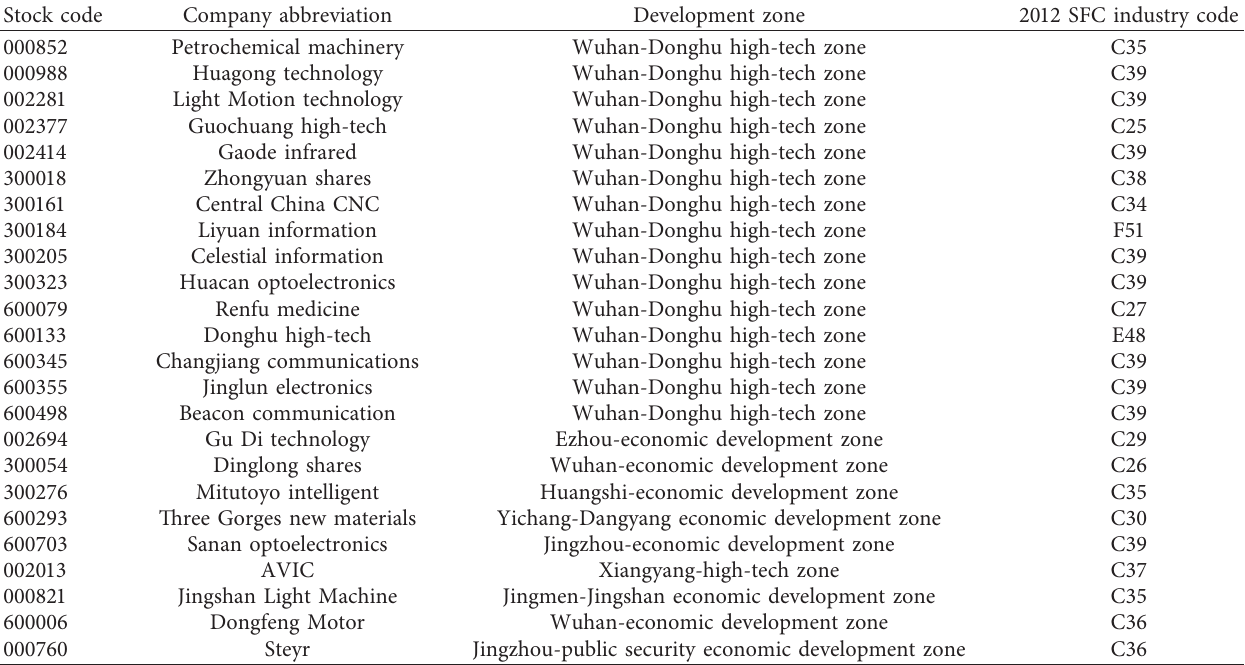
Table 2: Development zone and industry classification codes of 24 listed companies.